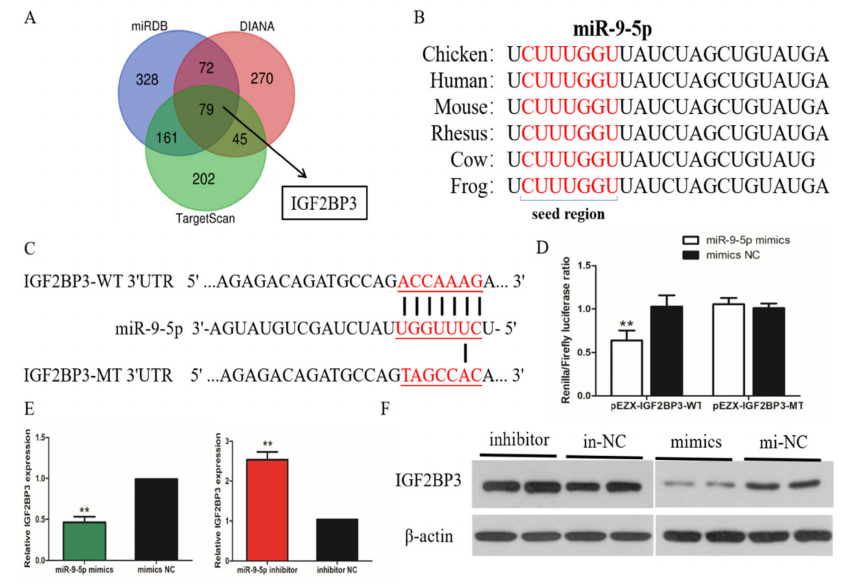
Figure 4. MiR-9-5p targets directly IGF2BP3 gene. ( A ) The prediction of target genes using TargetScan, miRDB and Diana. ( B ) The seed region of miR-9-5p. ( C ) The dual-luciferase reporter gene (pEZX-FR02) with wild type (pEZX-IGF2BP3-WT) or mutant (pEZX-IGF2BP3-MT). ( D ) The luciferase assays were performed by the co-transfection of wild-type or mutant IGF2BP3 3’ UTR with a miR-9-5p mimic or mimic-NC in SMSCs. ( E , F ) After transfection of miR-9-5p mimics, miR-9-5p inhibitor, or NC, the expression of IGF2BP3 was determined by q-PCR and Western Blot. The data are expressed as mean ± SEM ( n = 6). * p < 0.05; ** p <